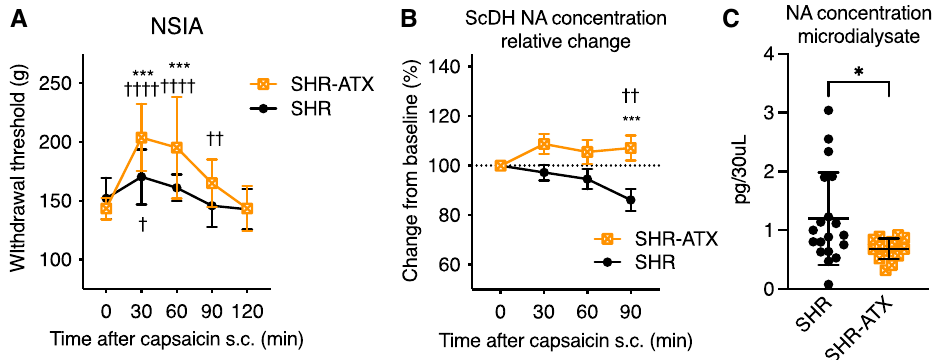
Figure 4. Repeated atomoxetine treatment restored noxious stimuli-induced anesthesia (NSIA) in SHR A standard treatment for ADHD, atomoxetine (0.3 mg/kg/d i. p . for 14 d), restored capsaicin-induced NSIA, which is impaired in SHR ( A ). The same atomoxetine treatment restored the capsaicin-evoked spinal noradrenaline increase ( B ) and reduced the spinal basal concentration ( C ). Mean ± SD, *; p < 0.05, **; p < 0.01, ***; p < 0.001 versus SHR, †; p < 0.05, ††; p < 0.01, ††††; p < 0.0001 versus time 0. n = 16 each ( A ), n = 17, 15 ( B , C ). ScDH: spinal dorsal horn, NA: noradrenaline, ATX: atomoxetine, POD: postoperative day, SHR: spontaneously hypertensive rats (ADHD model), SHR-ATX: atomoxetine treated